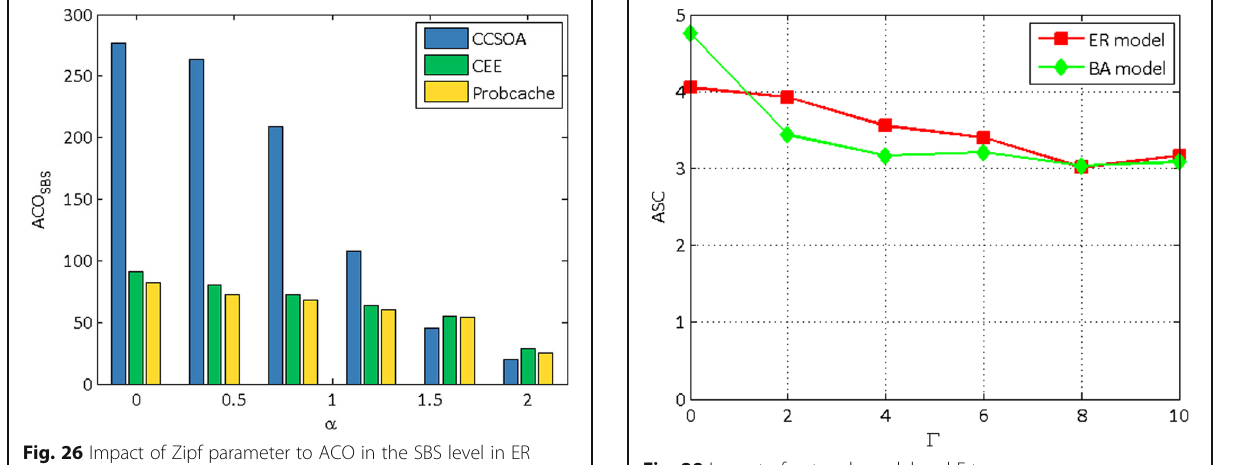
Fig. 28 Impact of network model and Γ